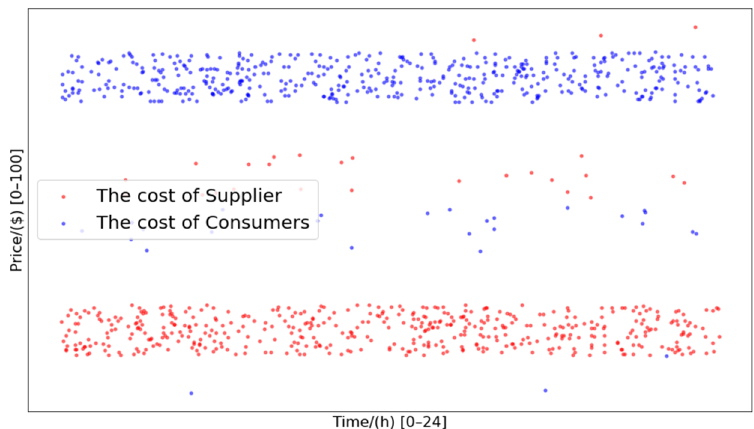
Figure 5. The schematic diagram of participant cost structure.